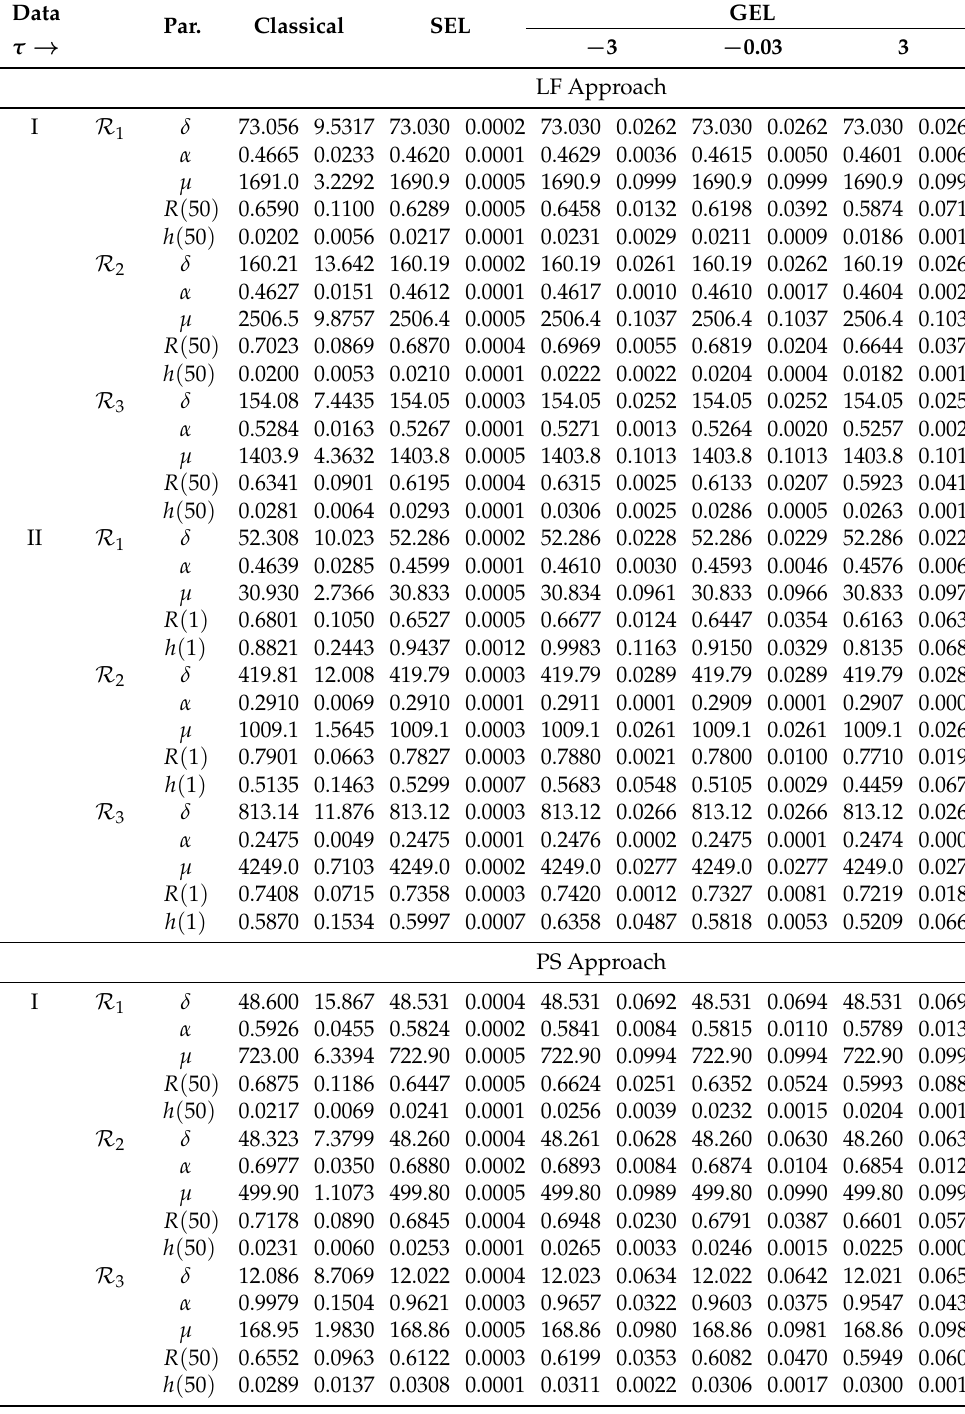
Table 6. Point estimates (first column) with their St.Es (second column) of δ , α , µ , R ( t ) and h ( t ) based on data sets I and II. Data